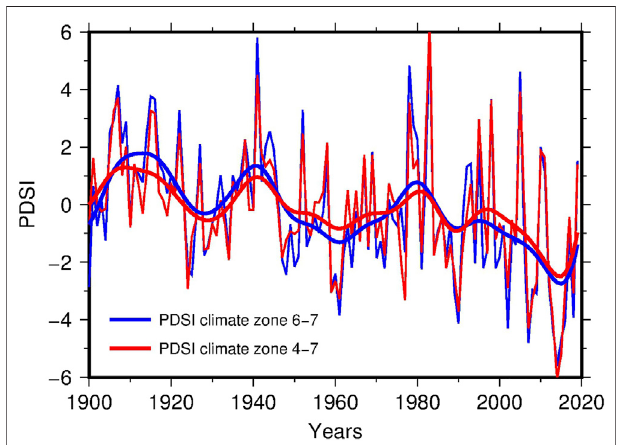
FIGURE 3 | PDSI averaged over the climate zones 6 – 7 (thin blue line) and 4 – 7 (thin red line). The thick lines are the corresponding smoothed curves obtained by Gaussian kernel smoothing with bandwidth parameter h (cid:1) 4 years.